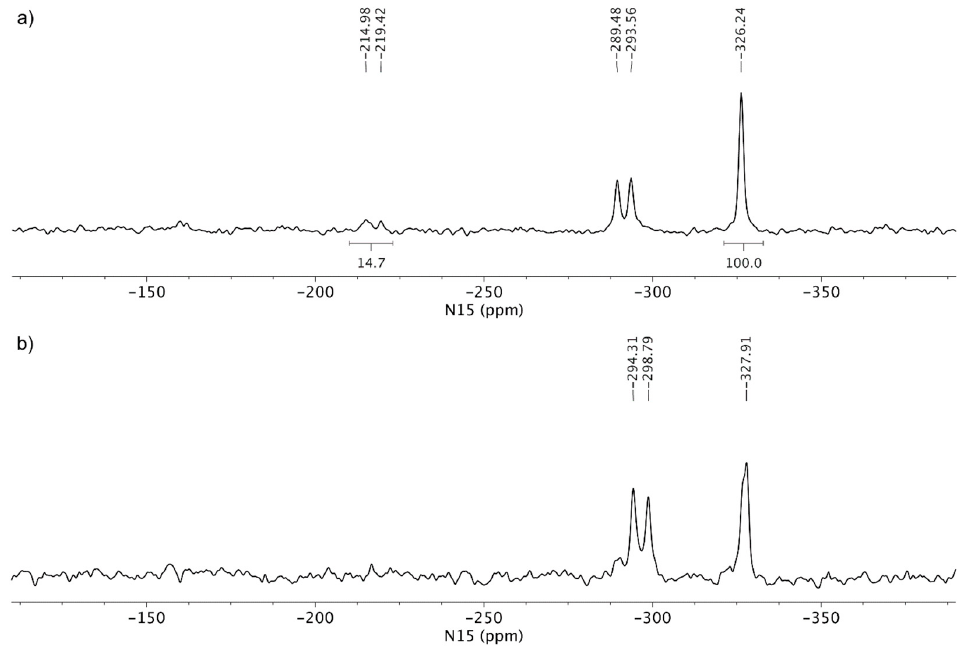
Figure 8. 15 N LG-CP MAS NMR spectra of ( a ) TA MF1 and ( b ) TA MF3. Both spectra were acquired using a relaxation delay of 1 s and ca. 200,000 scans. The relative integral value of protonated purine nitrogen is reported with respect to the integral region of amine nitrogen, which was arbitrarily set at 100.